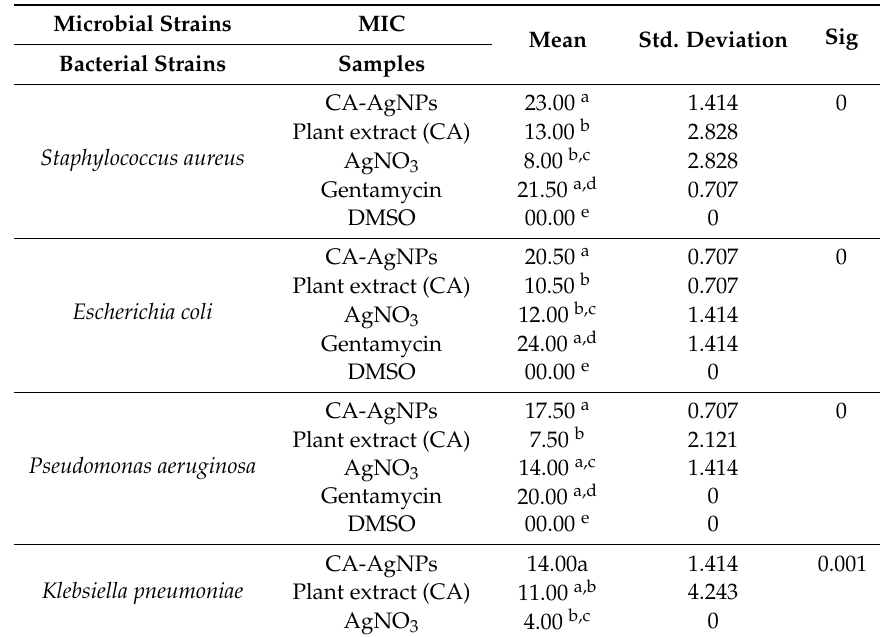
Figure 9. Histogram representation of the antibacterial results. Table 2. Descriptive table for antibacterial